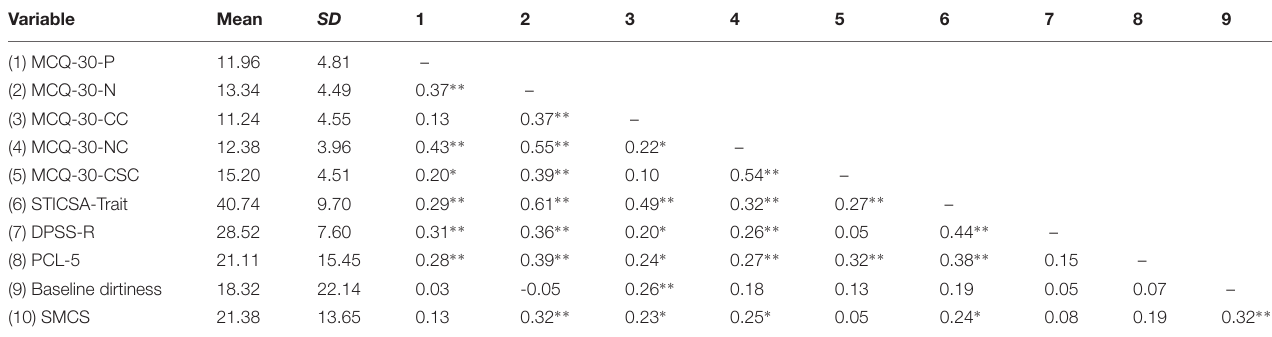
TABLE 1 | Descriptive statistics and zero-order correlations.